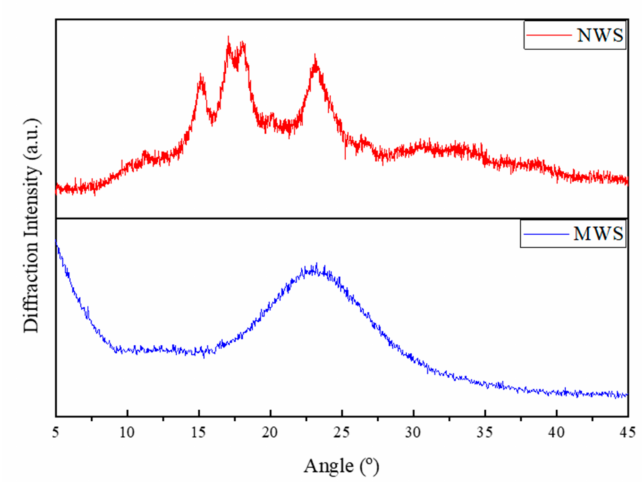
Figure 4. X-ray Diffractometry spectra of NWS, and MWS starch